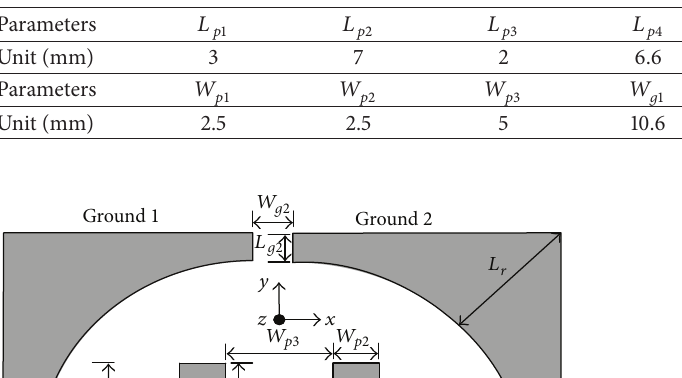
Table 1: Proposed antenna design parameters.